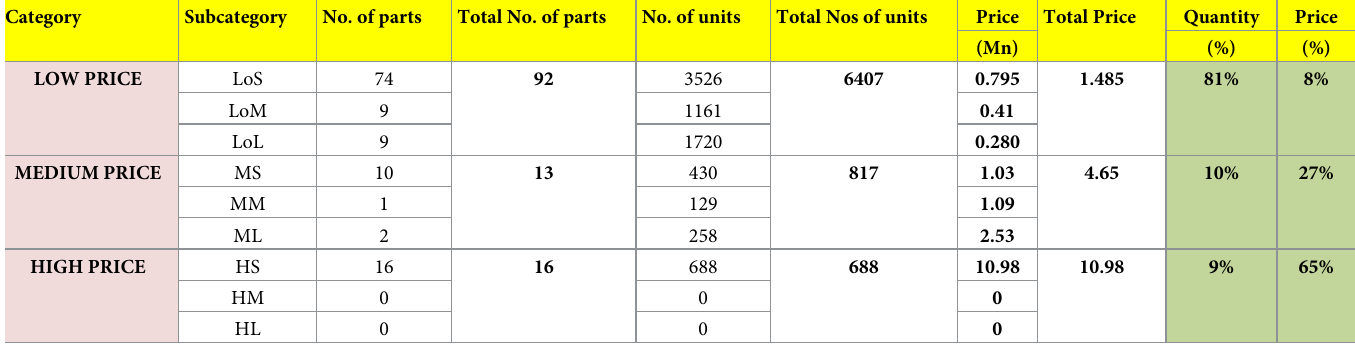
Table 5. Price based analysis.